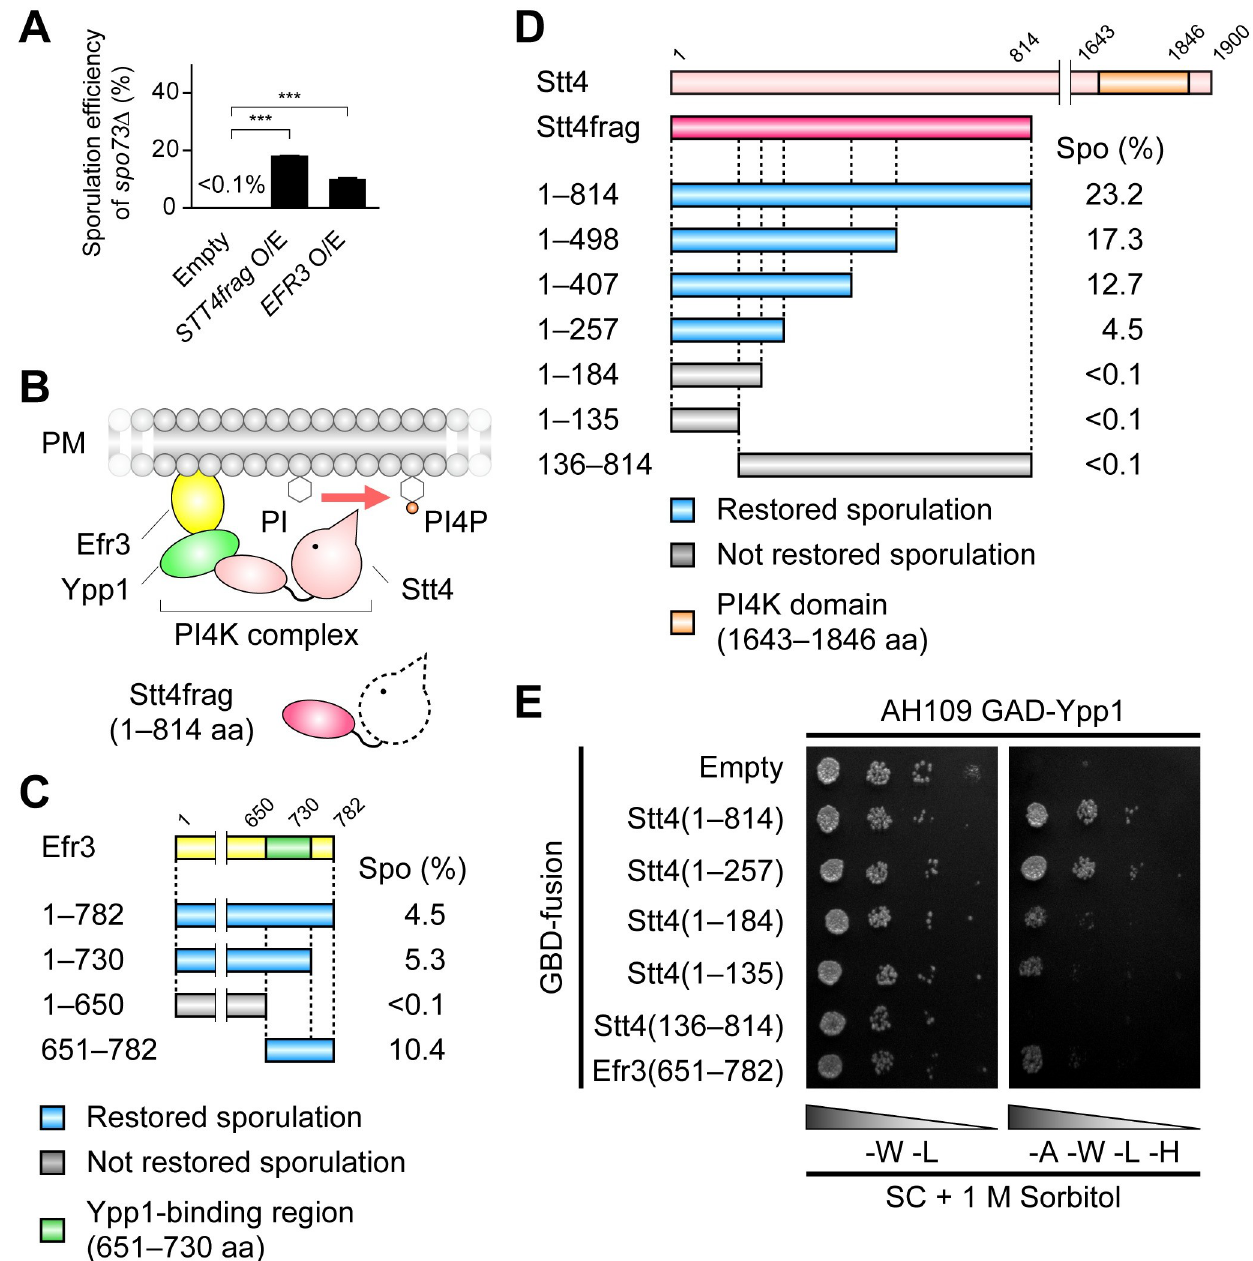
Fig 1. Overexpression of EFR3 or truncated STT4 partially suppress the sporulation defect of spo73 Δ . (A) Percentage of asci in spo73 Δ (TC545) overexpressing STT4frag , EFR3 , or harboring empty vector (control). More than 200 cells were observed in three independent colonies of each strain harboring indicated plasmids (for a total of > 600 cells). The bar graph shows the mean of the percentage of asci (N = 3). ��� , p < 0.001 (Dunnett’s test). (B) Diagram of PI4K complex on the PM. Stt4frag is an N-terminal fragment of Stt4 (1–814 aa). (C) Assessment of sporulation of spo73 Δ (TC545) by overexpression of constructs encoding a Efr3 deletion series. Spo (%) indicates the percentage of asci containing refractile spore(s). Light blue and gray boxes indicate deletion mutants that restored sporulation, or not, respectively. The green box indicates the Ypp1-binding region (651–730 aa). (D) Assessment of sporulation of spo73 Δ (TC545) by overexpression of constructs encoding a Stt4 deletion series. Diagram is shown as in (C). Orange box indicates PI4K domain (1643–1846 aa). (E) Assessment of binding of Ypp1 and Stt4 fragments by yeast two-hybrid assay. AH109 cells producing GAD-Ypp1 and indicated GBD-fusion proteins were cultured, and 10-fold serial dilutions were spotted onto SC plates depleted of tryptophan and leucine (-W -L), or depleted of adenine, tryptophan, leucine and histidine (-A -W -L -H) containing 1 M sorbitol for osmotic adjustment. Each plate was incubated for 2 days at 30˚C. Binding of Ypp1 and a Efr3 fragment was assessed as a positive control for functionality of GAD-Ypp1.